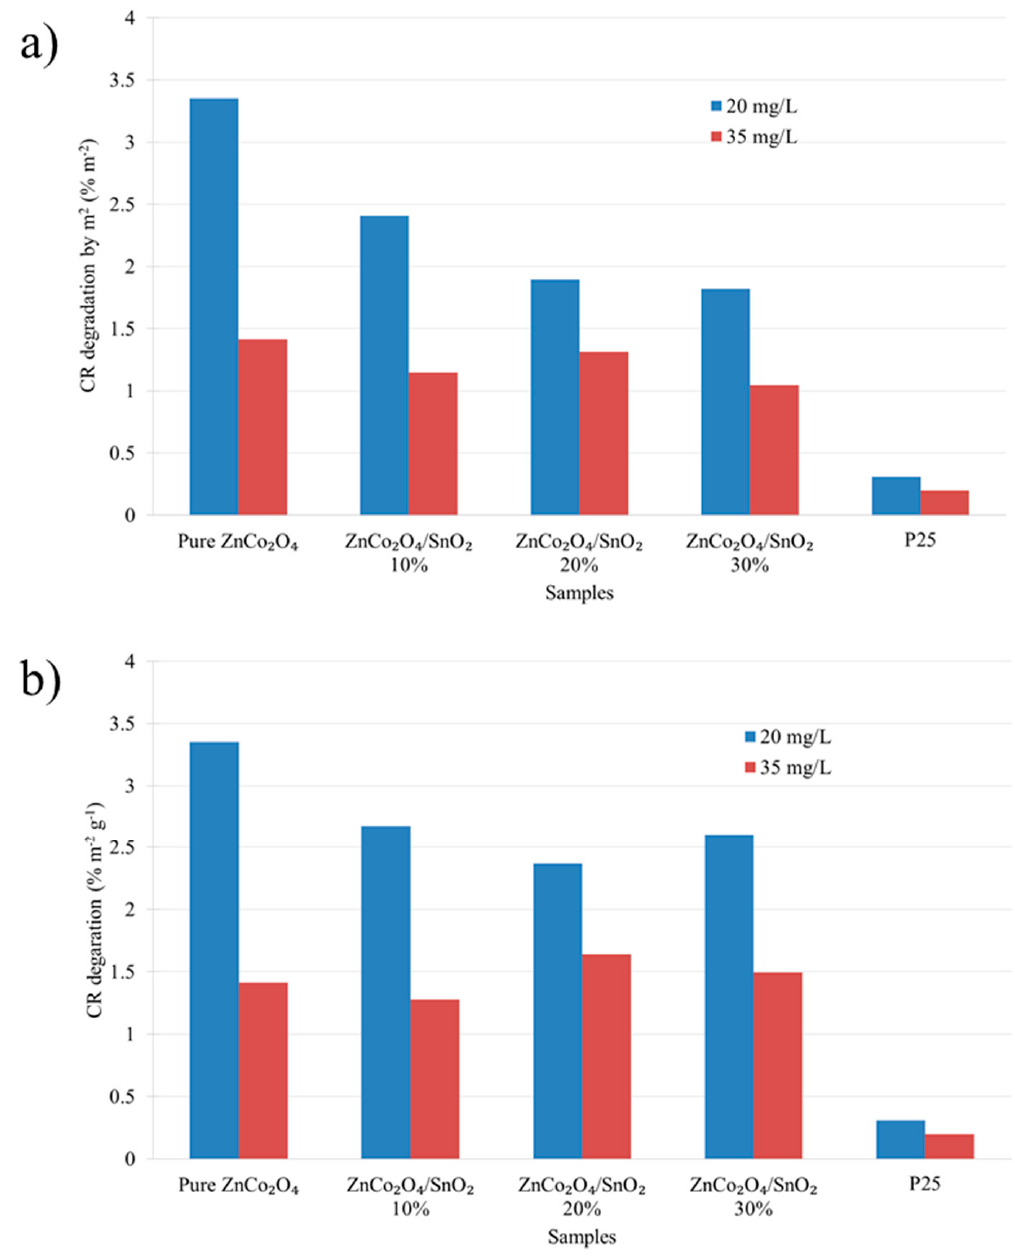
Figure 11. ( a ) CR degradation per m 2 (% m − 2 ) for all the samples under visible light ( λ > 400 nm) after 6 h of illumination; and ( b ) CR degradation per m 2 and per g of ZnCo 2 O 4 (% m − 2 · g − 1 ) for all the samples under visible light ( λ > 400 nm) after 6 h of illumination. For the Evonik P25, the photoactivity is reported to the mass of TiO 2 .